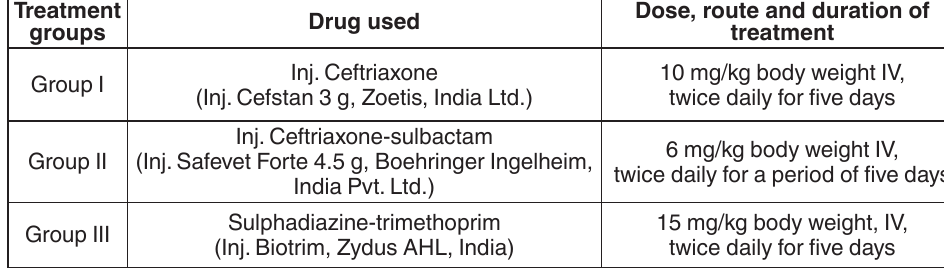
Table No 2. Statistical analysis of the three treatment trials